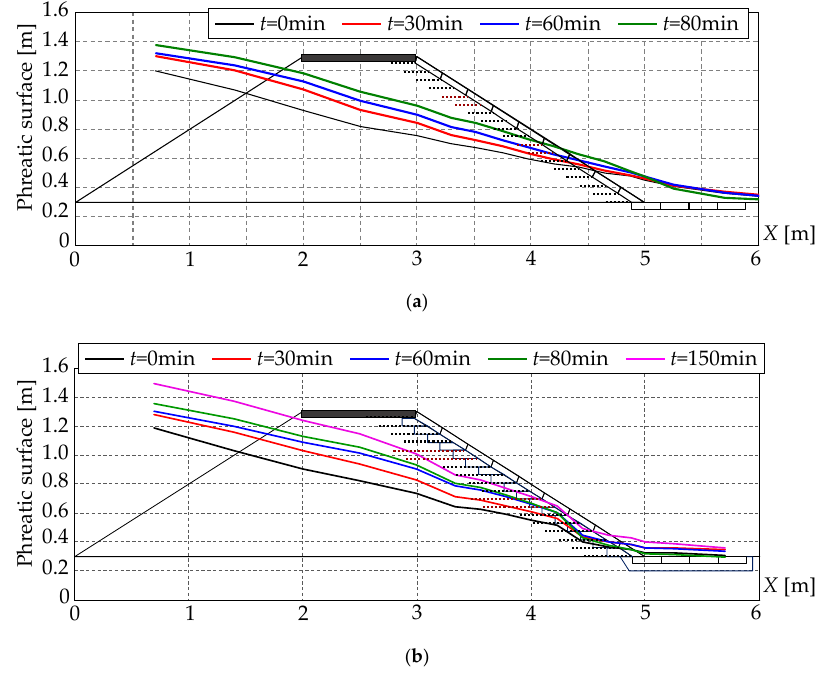
Figure 9. Temporal variations of phreatic surface in the levee body under the overflow: ( a ) Case B (GRS levee); ( b ) Case C (LDR levee).